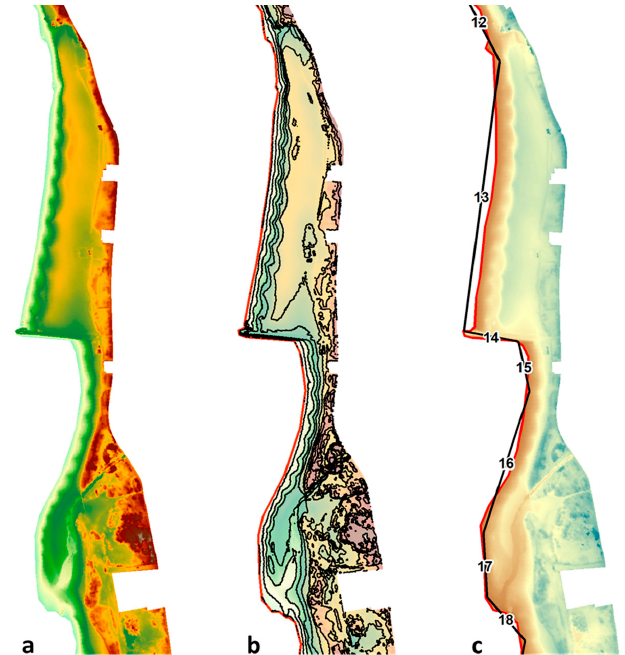
Figure 7. Segmentation of the coastal stretch for local analysis (only part of the stretch is shown): November 2008 DEM ( a ); contours (1 m above MSL contour in red) ( b ); and the simplified contour line (in black) providing the segments used for analysis, with their length and facing direction ( c ).